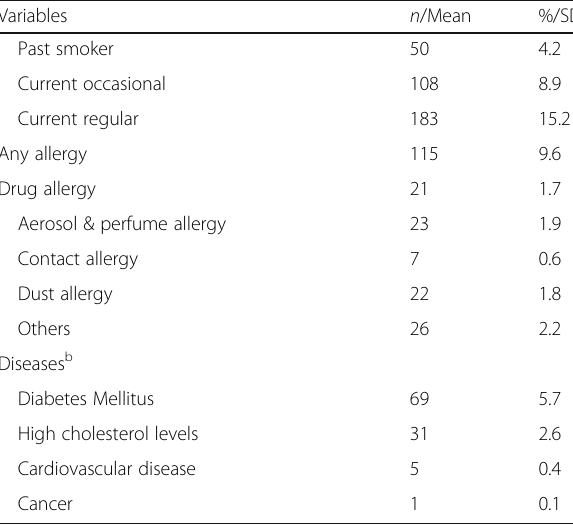
Table 2). The majority (88.3%) of HS users purchased